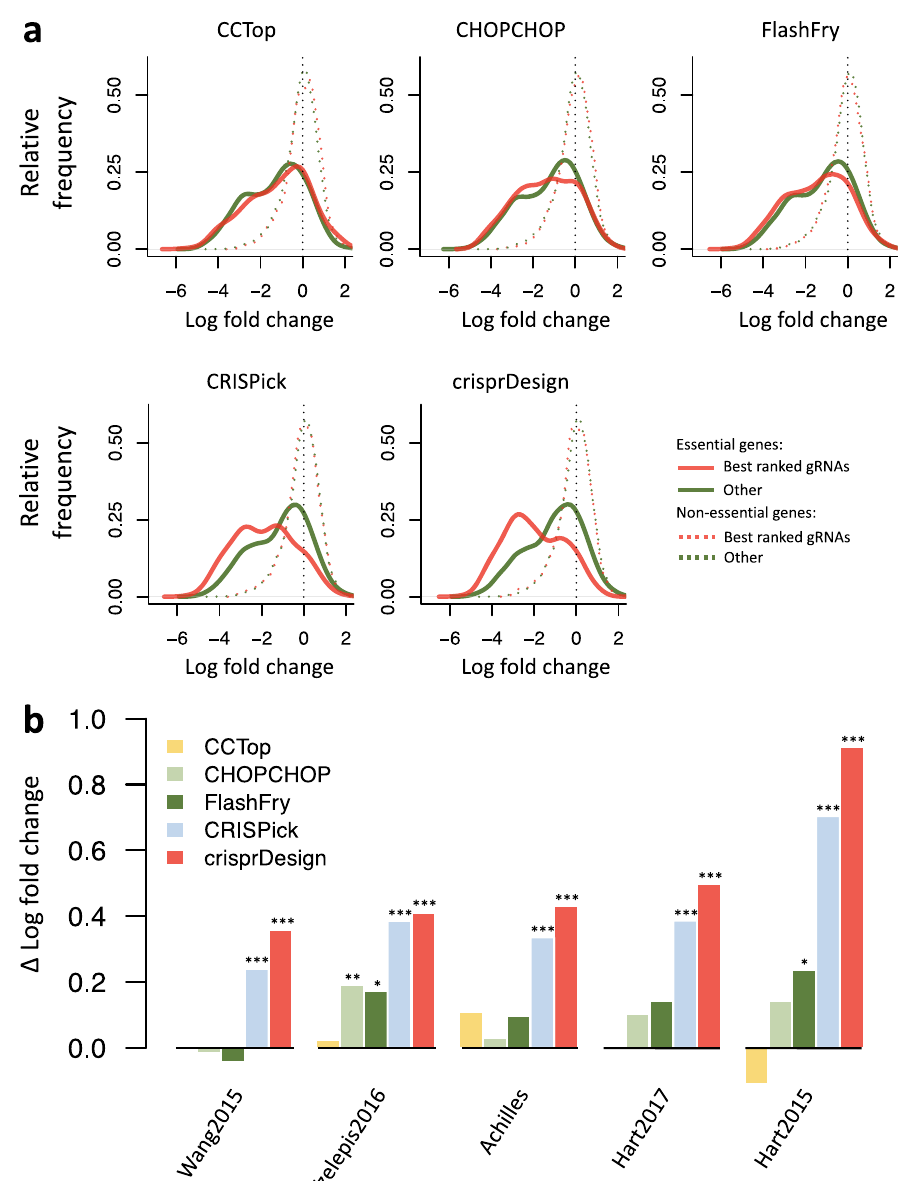
Fig. 3 | Comparison of CRISPRko Cas9 gRNA rankings for protein-coding humangenes. WedesignedandrankedgRNAstargetingallprotein-codinghuman genes (Ensembl release 104) using tools that provide gRNA rankings: CCTop , CHOPCHOP , FlashFry , CRISPick and crisprDesign . To compare gRNA ranking per- formance across tools, we obtained gRNA LFCs from 5 genome-wide CRISPRko fi tness screening datasets, listed in Table 3. In these fi tness screens, active gRNAs targeting essential genes are expected to drop out and show negative LFCs. To investigate the relationship between gRNA activity and gRNA ranking, we con- sidered for each gRNA library the subset of gRNAs targeting a common reference set of essential genes 72 . For each gene and tool, we identi fi ed the top 15 ranked gRNAs based on the tool-speci fi c in silico ranking. a LFC distributions in the Hart2015 dataset for gRNAs targeting essential genes (solid lines) and gRNAs tar- geting non-essential genes (dotted lines). Red lines show the distributions of the